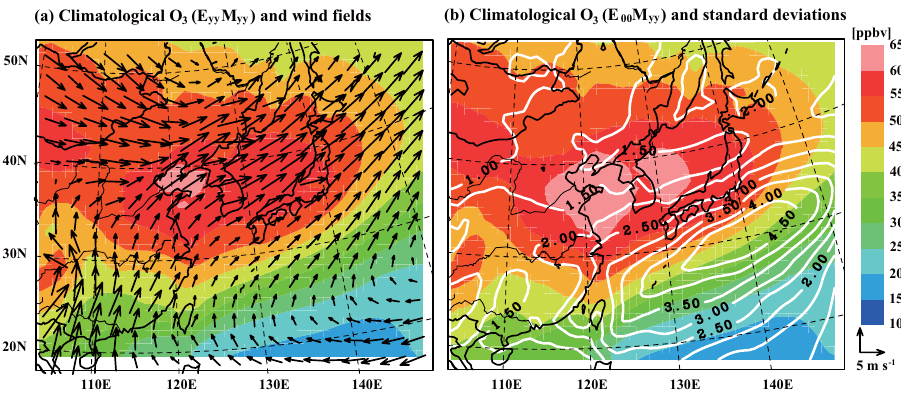
Fig. 4. (a) Spatial distributions of simulated springtime BL O 3 averaged over 1981–2005 for the E yy M yy scenario, overlaid with the springtime climatological wind field in the BL. (b) The same as in (a) for the E 00 M yy scenario, overlaid with the standard deviations of O 3 mixing ratios, calculated at each grid point using the simulated fields for each year and the 25-year